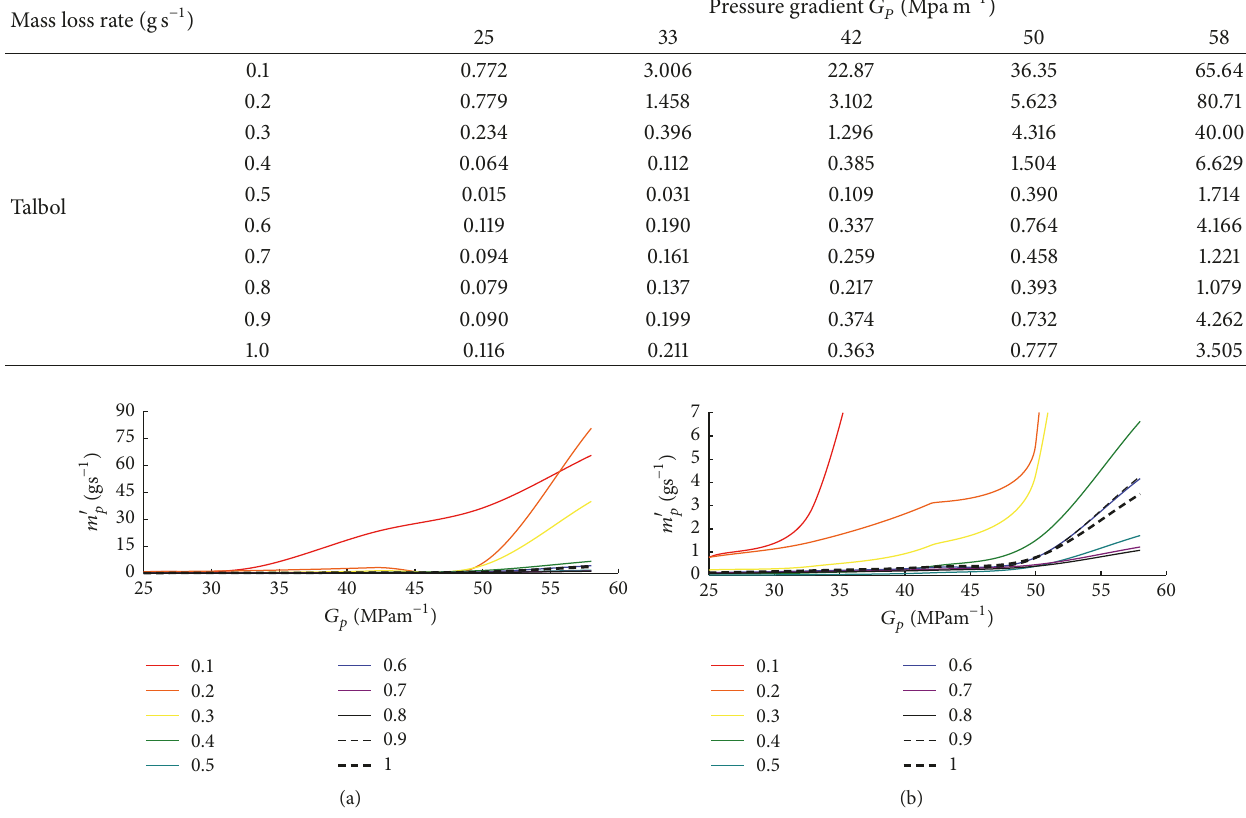
Table 5: Mass loss rate (g s −1 ) of tested samples at different Talbols and pressure gradients.